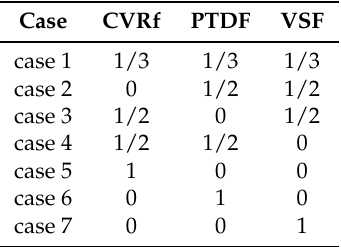
Table 8. Various cases with different weighting factors of H2.